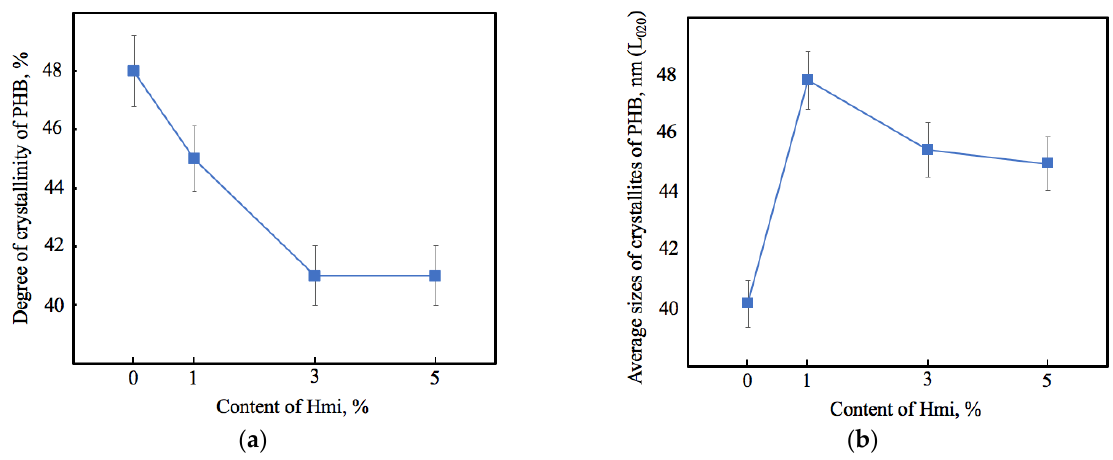
Figure 4. Degree of crystallinity ( a ) and average sizes of PHB crystallites L 020 ( b ) of PHB–Hmi